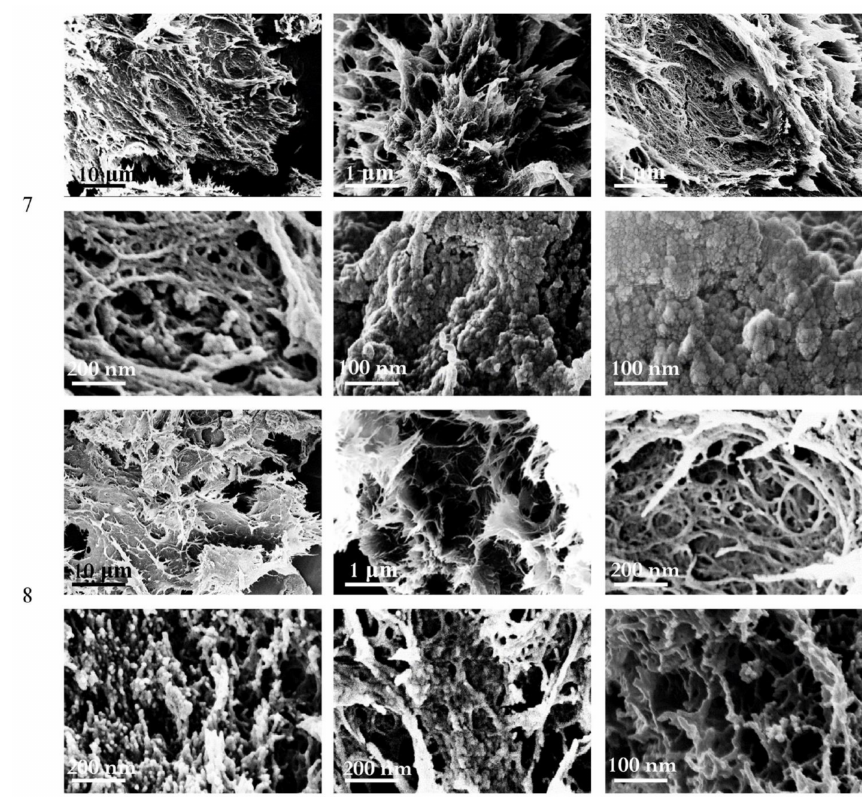
Figure 4. SEM images of cryogel samples 7 and